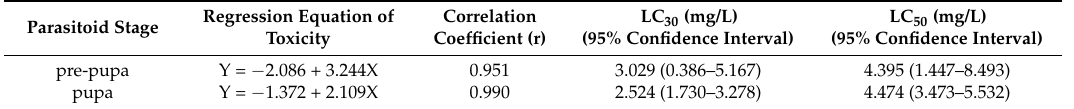
Table 5. Toxicity of abamectin to the pre-pupa and pupa of Encarsia formosa .